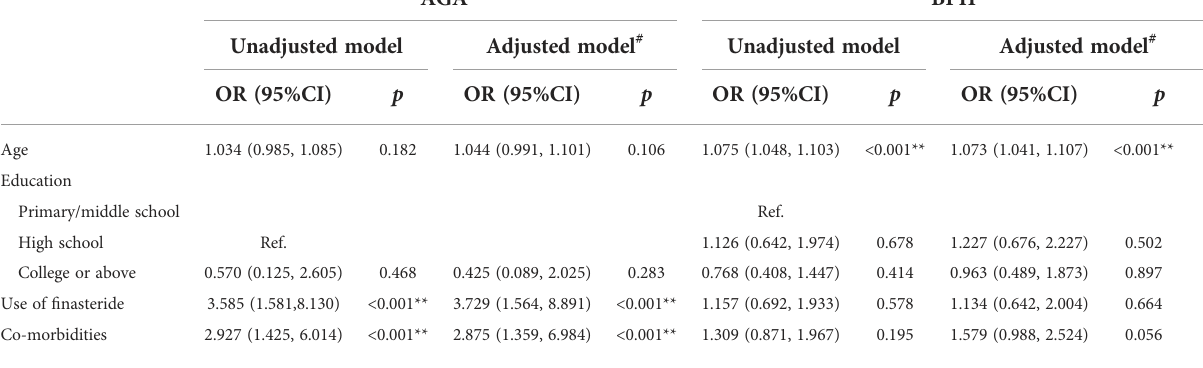
TABLE 2 Associated factors for unvaccination among AGA and BPH patients.